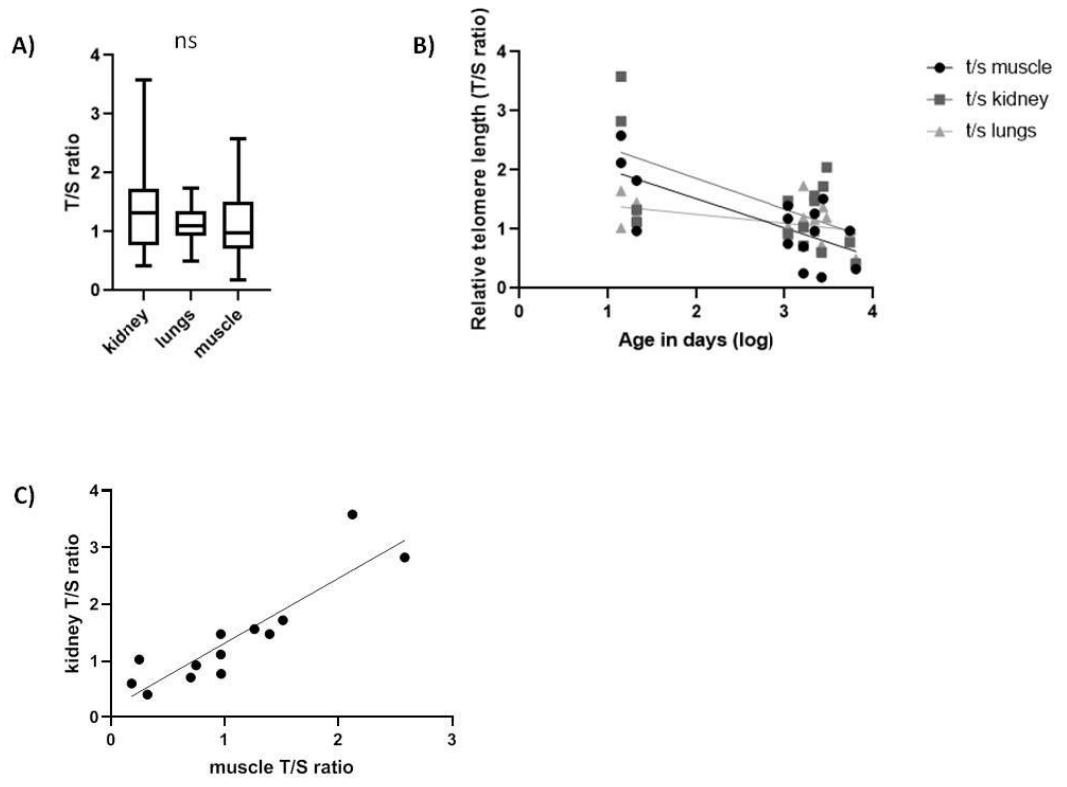
Figure 3. Relative telomere length (T/S ratio) in Spalax tissues. ( A ) range of rTL between all tissues ( N = 15, ns); ( B ) rTL as a function of age in kidney (slope = −0.08451, F 1,13 = 4.737, p < 0.05, R 2 = 0.2671), in lung (slope = −0.03415, F 1,14 = 5.759, p < 0.05, R 2 = 0.2915) and in muscle (slope = −0.0706, F 1,13 = 5.315, p < 0.05, R 2 = 0.2902); ( C ) correlation between kidney and muscle telomeres ( p = 0.001, r = 0.894).